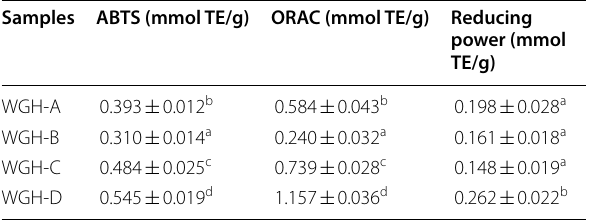
Table 2 Antioxidant activities of WGH-A, WGH-B, WGH-C and WGH-D